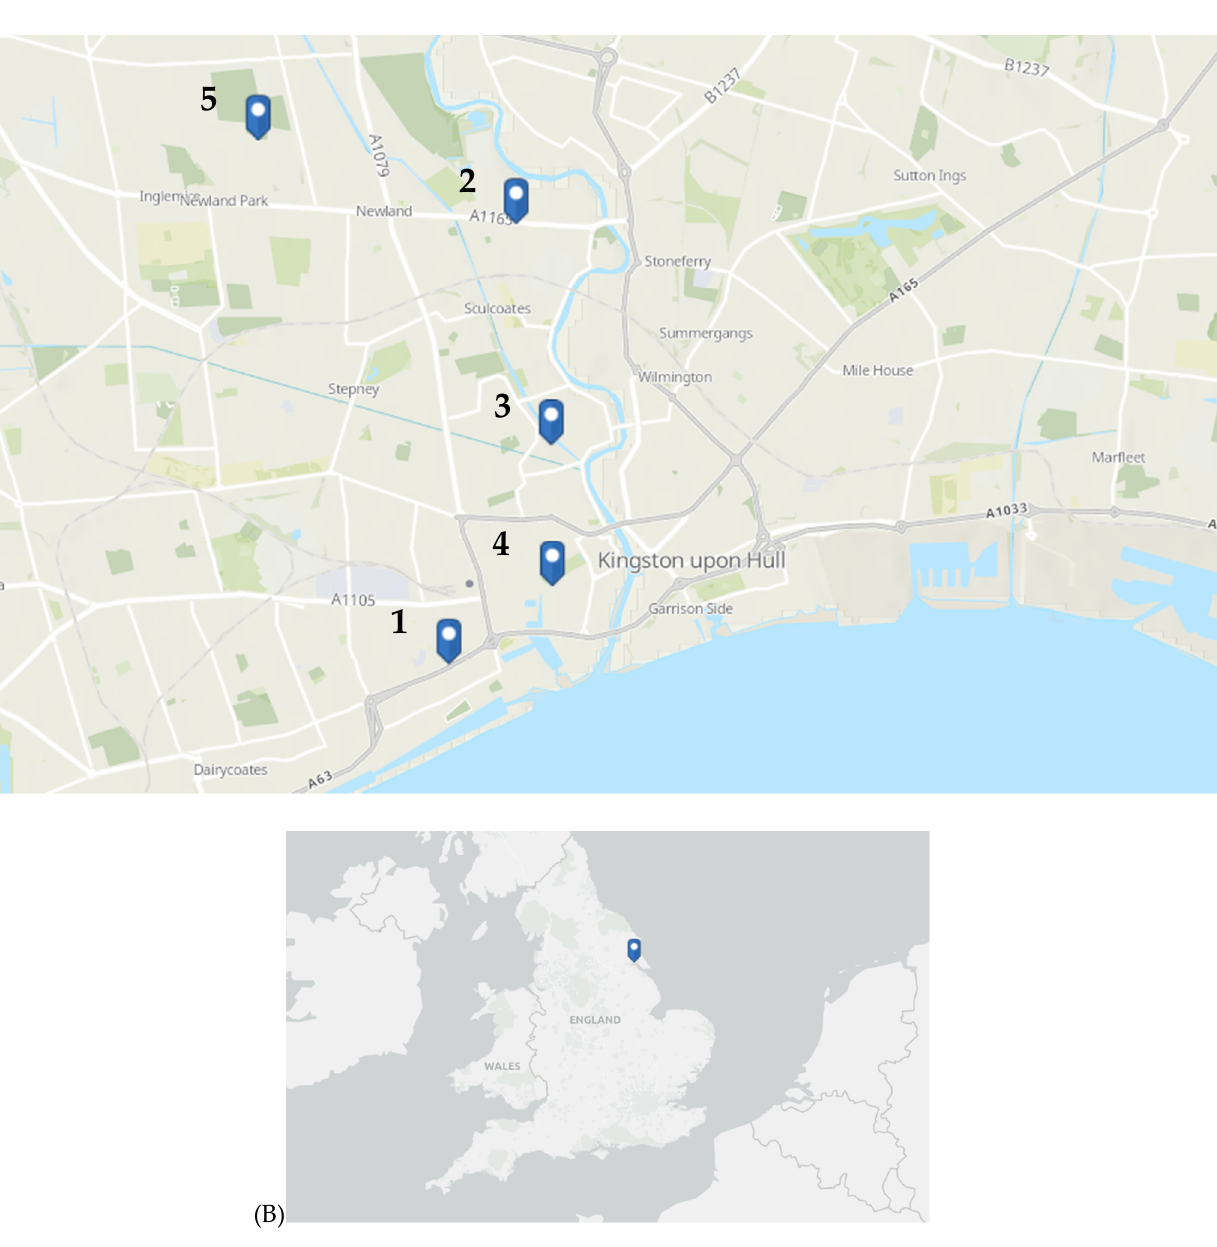
Figure 1. Map of the sampling locations chosen for atmospheric deposition sampling. ( A ). The sampling sites within Kingston upon Hull: A63 (Site 1), roadside commercial (Site 2), industrial (Site 3), city centre (Site 4), and university district (Site 5). ( B ). The location within the United Kingdom.